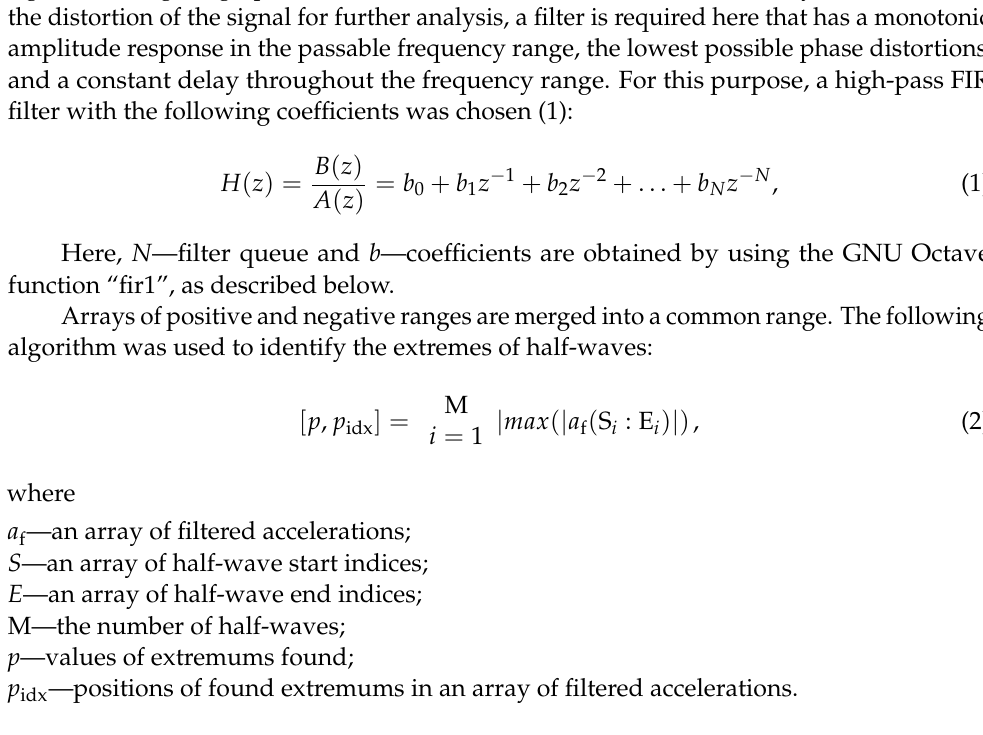
Figure 15. Spectrogram of acceleration along X-axis (handling cycle).